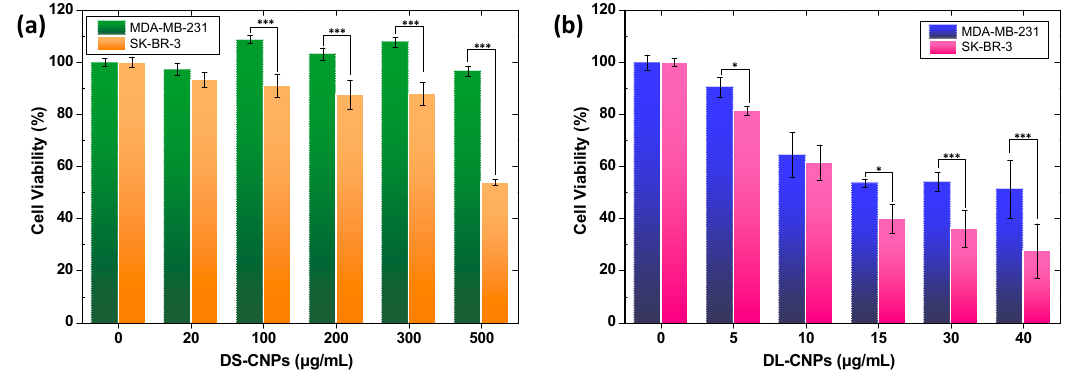
Figure 3. Cytotoxicity of ( a ) DS-CNPs and ( b ) DL-CNPs in SK-BR-3 and MDA-MB-231 cells after 48 h incubation (n = 6, * p < 0.05, *** p < 0.001).